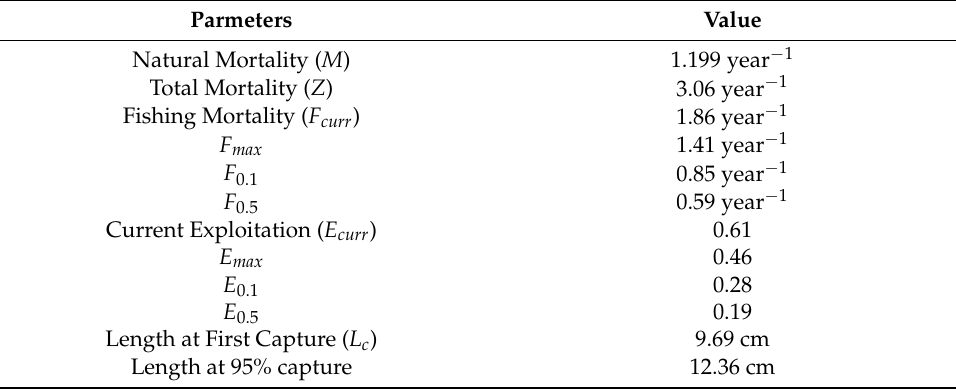
Table 3. Mortality and exploitation rate estimated by